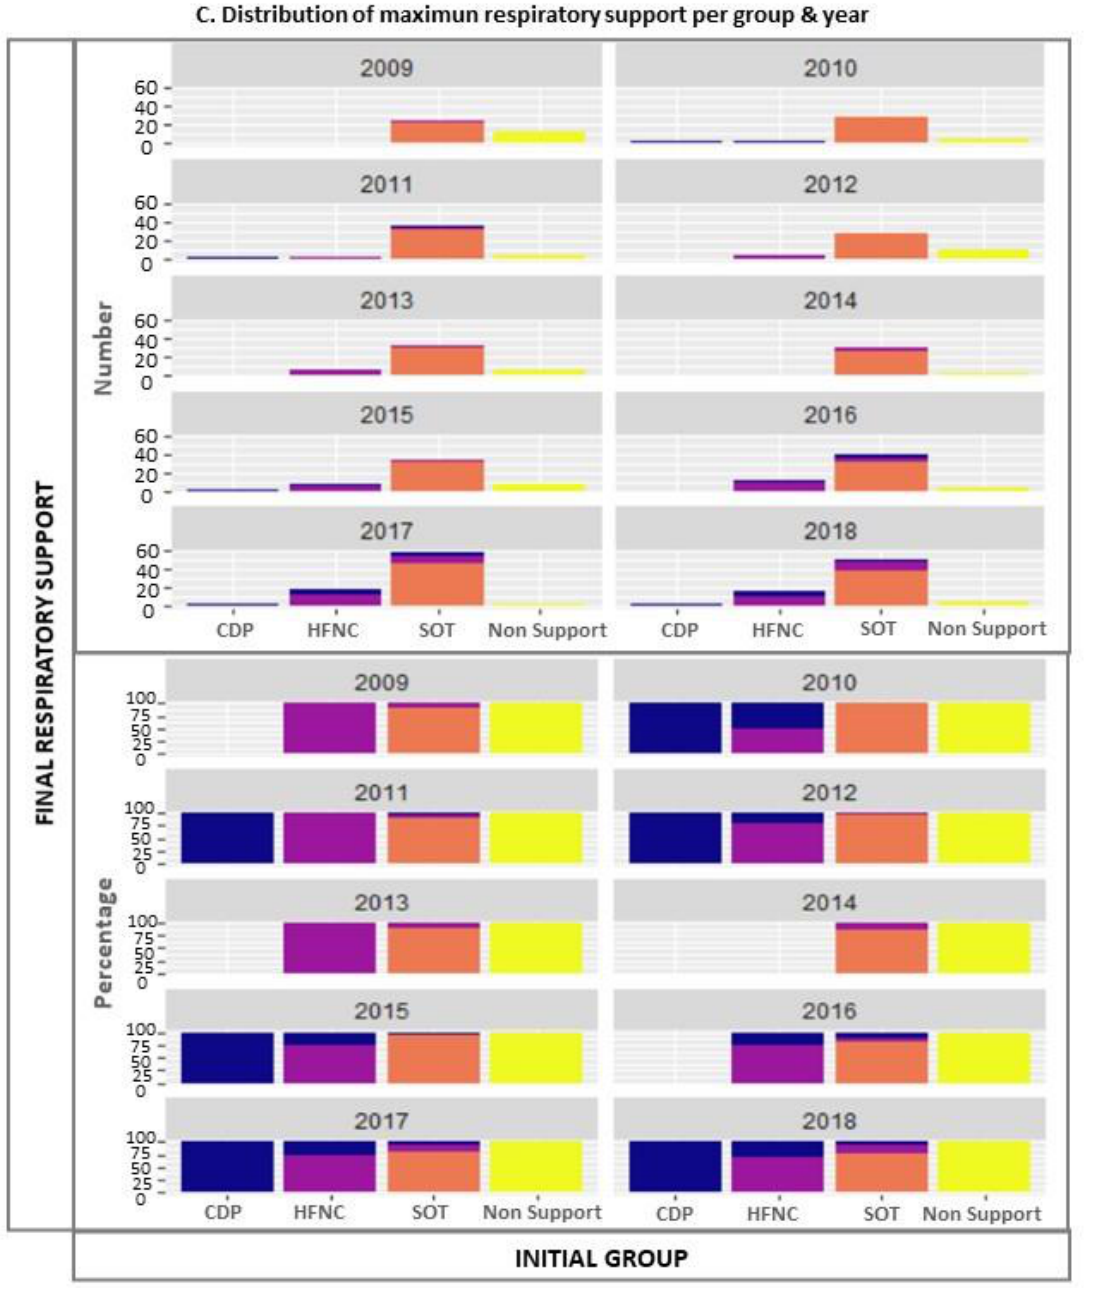
Figure 2. Distribution of initial groups per year and its maximum escalation of respiratory support in the hospital ward: ( A ) Total distribution of the groups according to the respiratory modality required for initial stabilisation; ( B ) maximum respiratory support for each of these groups during admission; ( C ) maximum escalation of respiratory support for each of these groups per year.